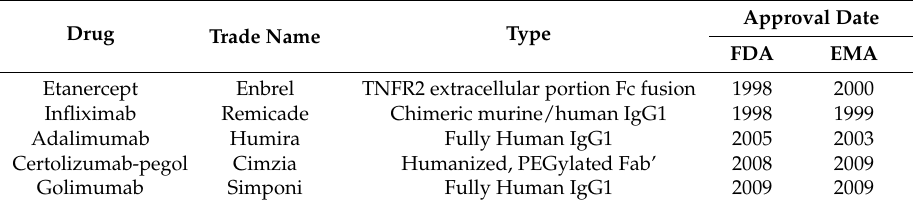
Table 2. Approved biologics against TNF- α